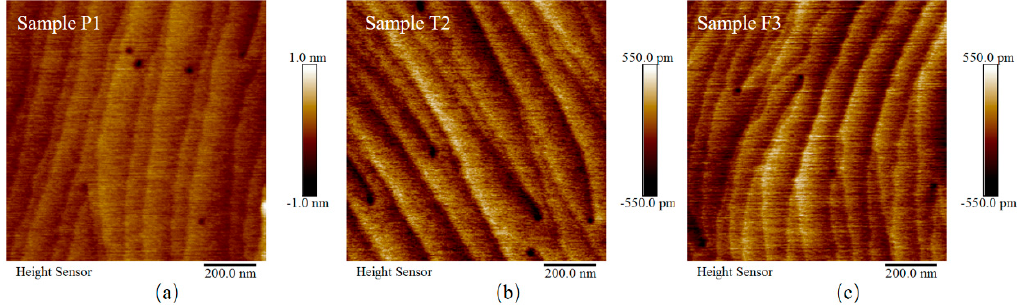
Figure 2. Atomic force microscopy images of samples P1, T2 and F3 in a 1 µ m × 1 µ m regions.